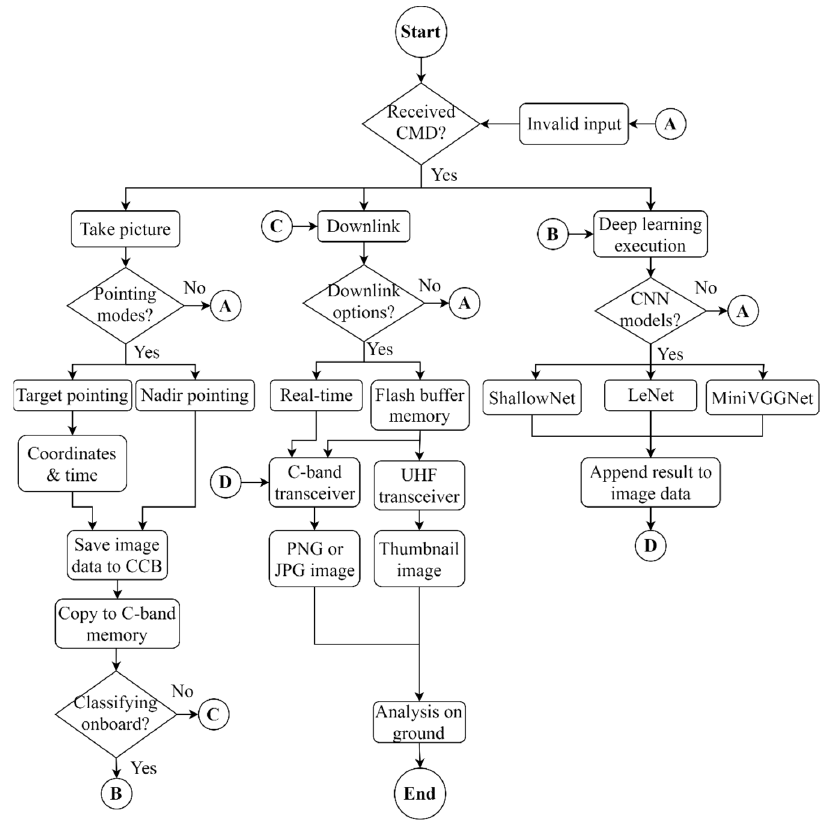
Figure 4. Camera mission with deep ‐ learning execution flowchart.